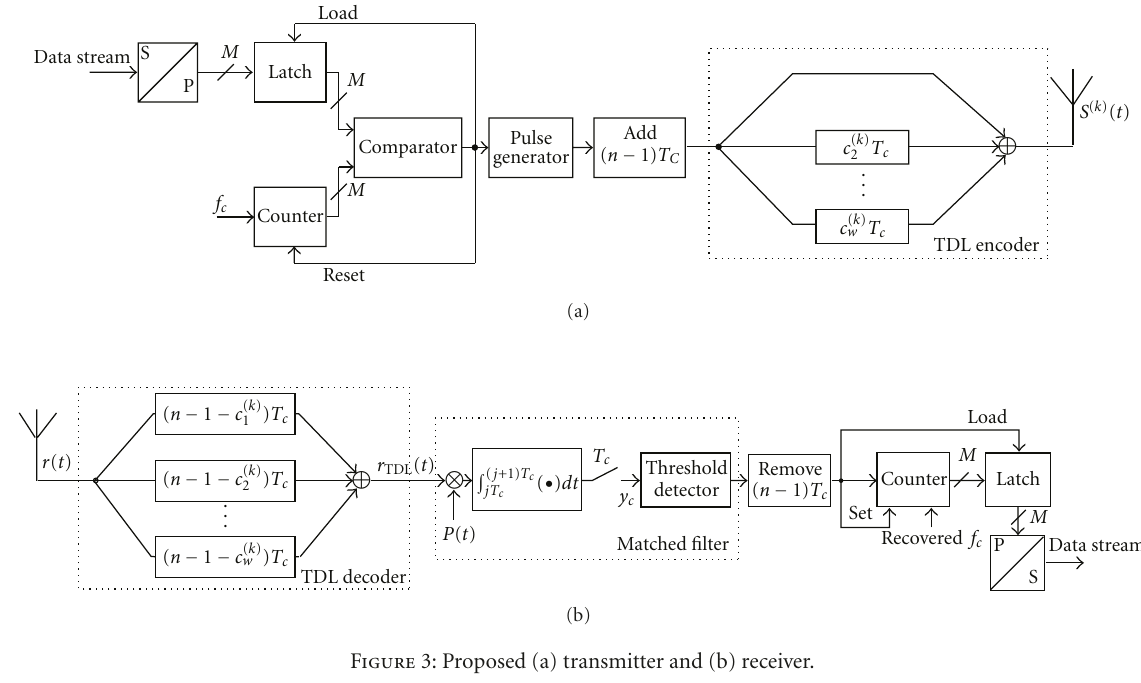
Figure 3: Proposed (a) transmitter and (b)